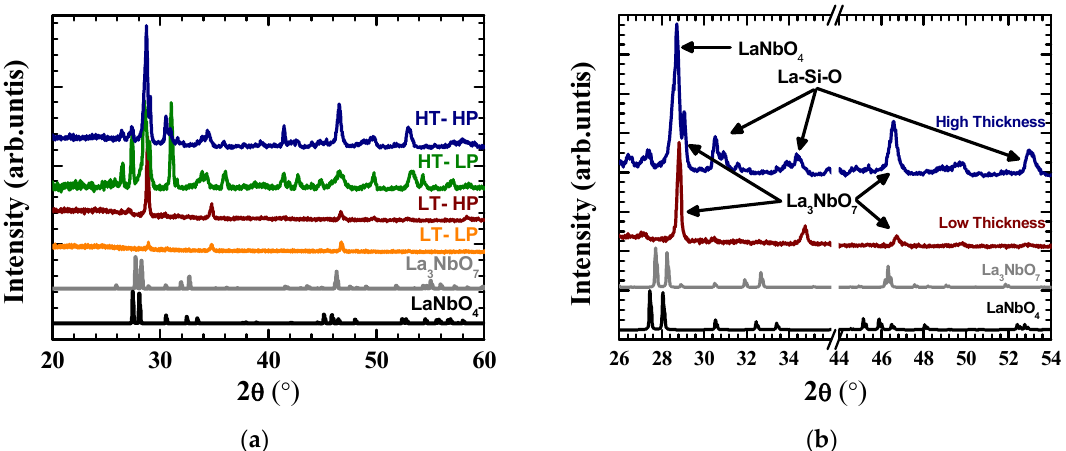
Figure 1. Comparison between the simulated patterns of the La 3 NbO 7 and LaNbO 4 reference com- pounds with ( a ) HR-XRD patterns of La 2.97 Nd 0.03 NbO 7 thin films grown under different sputtering conditions (high or low RF power and thickness); ( b ) smaller 2 θ angular range of HT and LT HR-XRD patterns of the sputtered thin films.